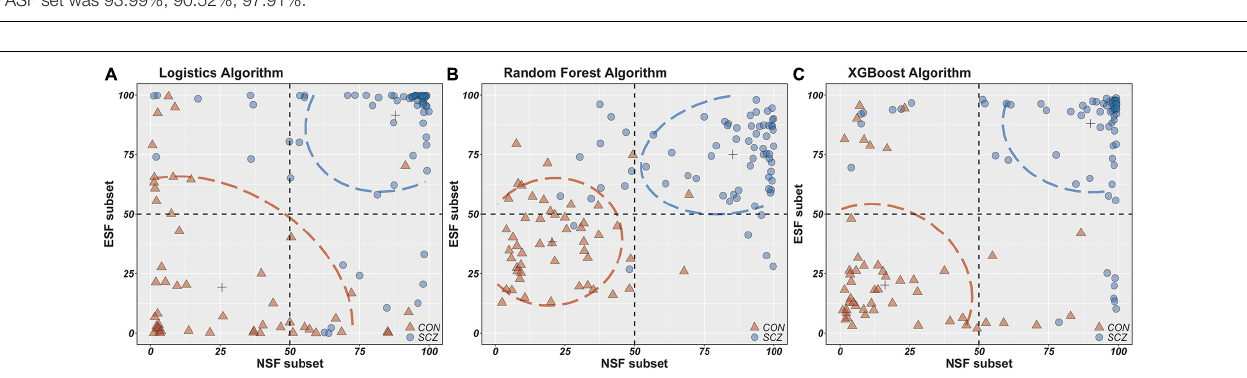
FIGURE 1 | Receiver Operator Characteristics (ROC) curves for classification of schizophrenia patients and controls based on different combinations of features using logistics (A) , random forest (B) , and XGBoost algorithm (C) . NSF subset, Neurocognitive Selected Features subset include IMM, LAN, ATT, DEM, INT-C, INT-W features; ESF subset, Electrophysiological Selected Features subset include PSC-PPI, PSS-PPI, Abs-T, Abs-A, Abs-AFp/AO, Abs-(D+T)/(A+B), Rel-D, Rel-T, Rel-A/B, DFA-A, DFA-B. ASF set, All Selected Features set include NSF subset and ESF subset. The red, green and blue lines show the ROC curves for the NSF subset, ESF subset and ASF set, respectively. The AUC of logistics models based on NSF subset, ESF subset, ASF set was 89.88%, 90.84%, 92.54%. The AUC of random forest models based on NSF subset, ESF subset, ASF set was 96.59 91.88%, 97.36%. The AUC of XGBoost models based on NSF subset, ESF subset, ASF set was 93.99%, 90.52%, 97.91%.